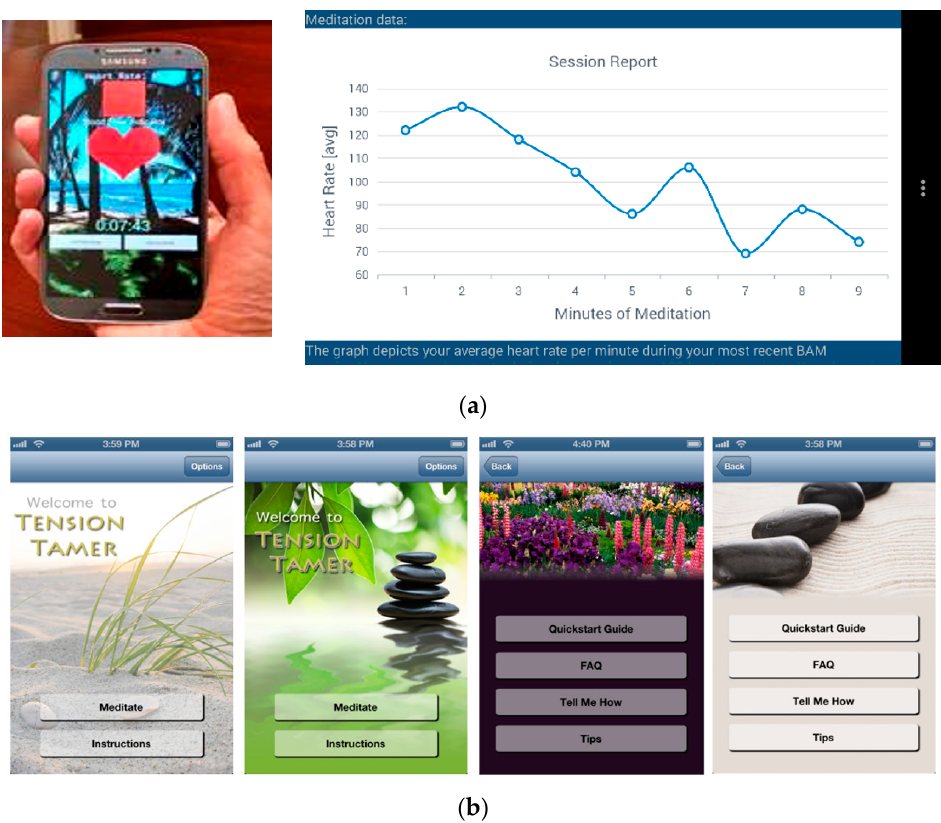
Figure 2. ( a ) Depiction of in-app heart rate acquisition and feedback graph; ( b ) Examples of setting options of the tension tamer mobile app.